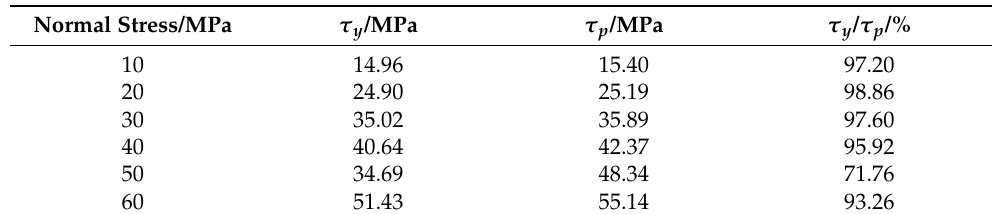
Table 3. Yield stress under various normal stresses .